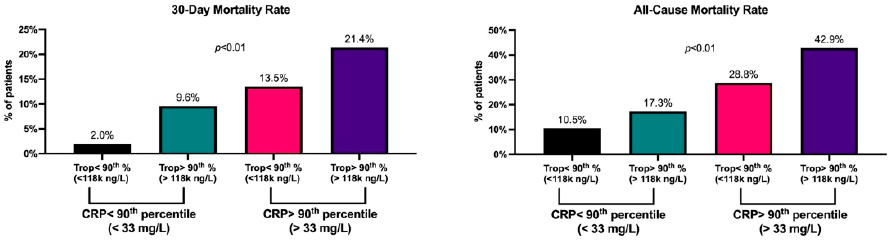
Figure 2. Combined CRP and Troponin Test (CTT) results and mortality rates. Bar graphs repre- senting the proportion of patients who died during follow-up according to their CRP Troponin Test (CTT) results. The median follow-up time for all-cause mortality was 4.5 years [IQR 3.1–6.3]. The bar colors correspond to the 4 groups presented in Figure 1. p -values were calculated by the Chi-Square test. Table 2. Binary logistic regression to predict 30-day mortality.